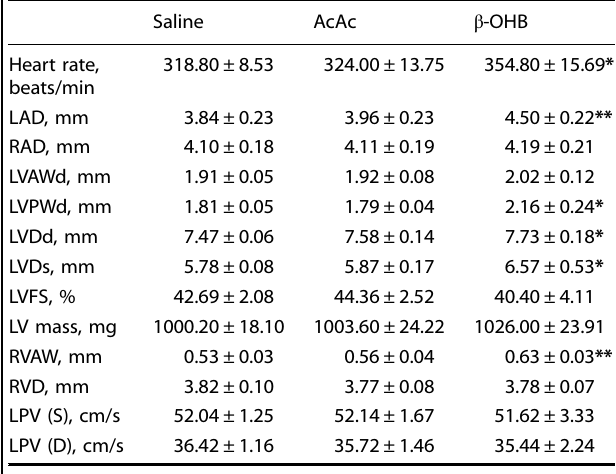
Values are mean ±SEM ( n = 6) LAD left atrial diameter, RAD right atrial diameter, LVAWd left ventricular anterior wall thickness, LVPWd left ventricular posterior wall thickness, LVDd left ventricular dimension in diastole, LVDs left ventricular dimension in systole, LVFS left ventricular fractional shortening, RVAW right ventricular anterior wall thickness, RVD right ventricular dimension, LPV left pulmonary venous fl ow, S Systolic, D diastolic * p <0.05, ** p <0.01 versus the saline group according to Student ’ s t